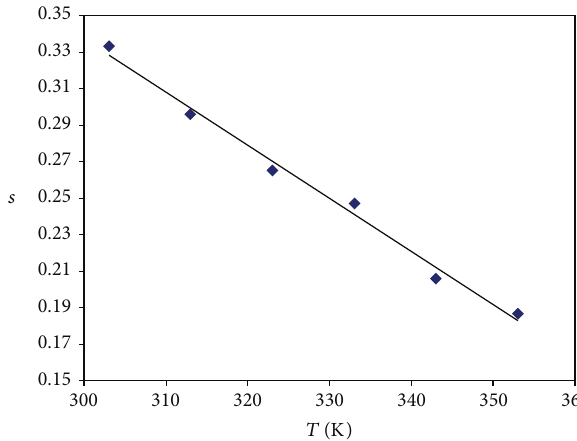
Figure 18: Frequency exponent ( 𝑠 ) versus temperature for poly-o-phenylenediamine